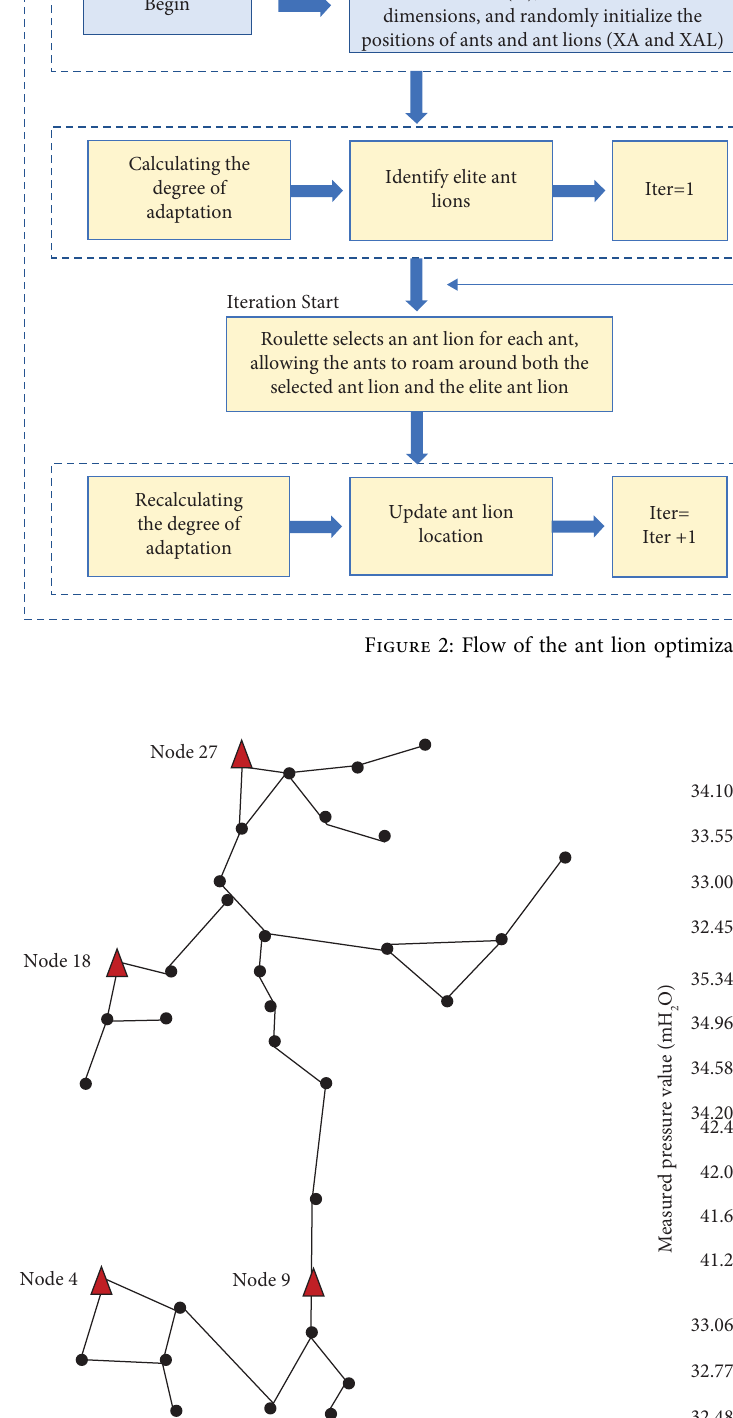
Figure 3: An example of a pipeline network pressure monitoring point arrangement scheme.